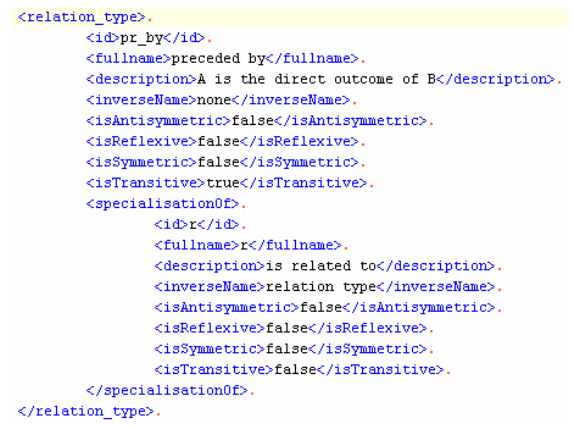
Figure 2 OXL metadata excerpt for pr_by relation